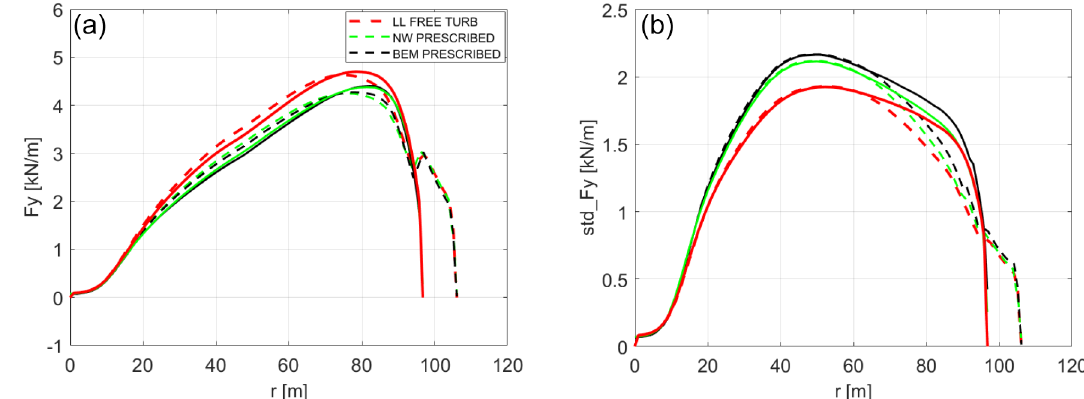
Figure 20. Out-of-plane force (a) mean distribution and (b) standard deviation. Solid lines represent the baseline blade, while dashed lines represent the optimized tip design.